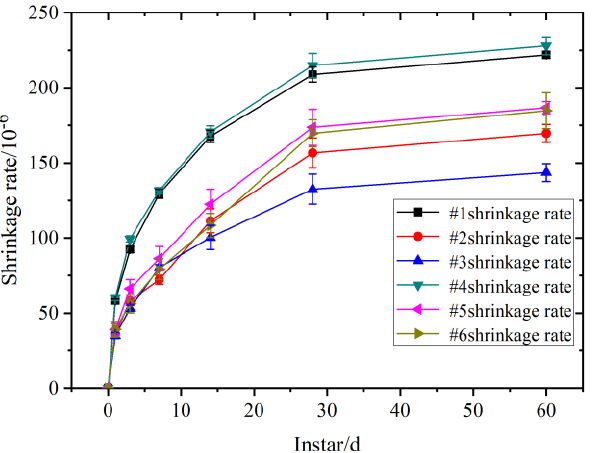
Figure 4. Trend of self-shrinkage with age for different strength classes and parts of the base con- crete.